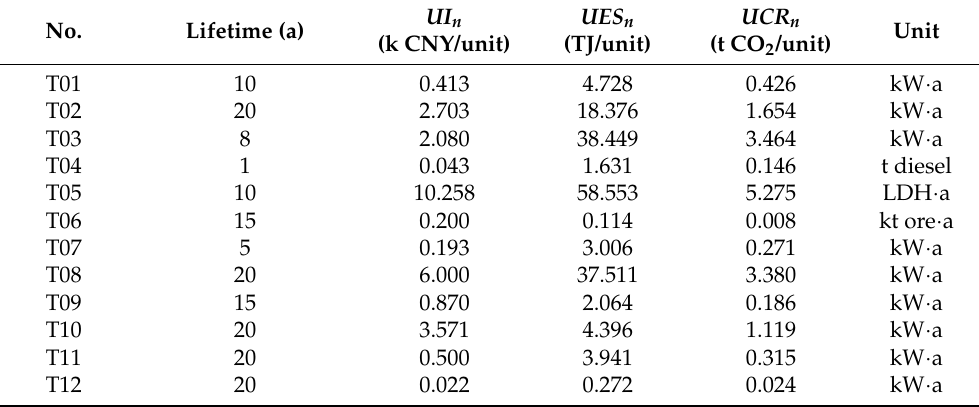
Table A2. Inputs required for the energy conservation supply curve and carbon abatement cost curve of different ECCA